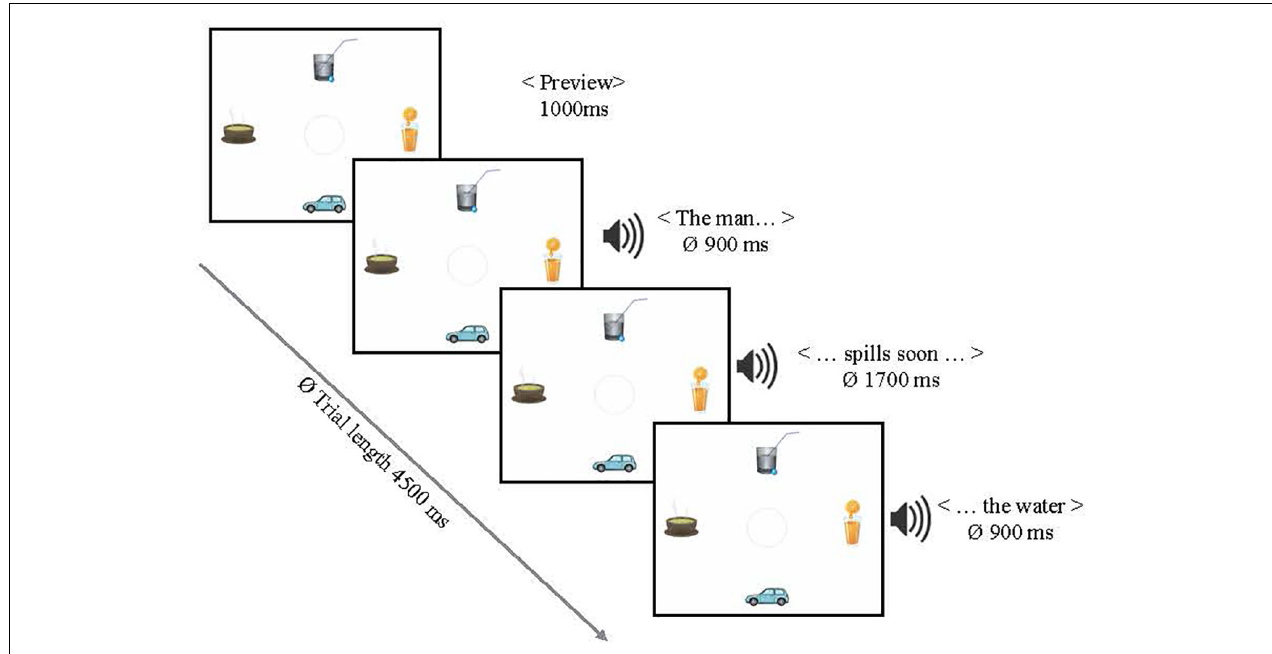
FIGURE 7 | A trial example or Experiment 4. The example scene shows three possible target referents.